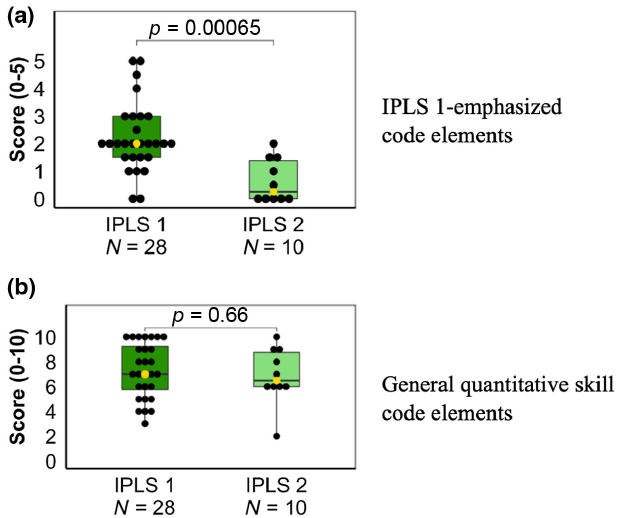
FIG. 4. Score comparison between those who had taken different IPLS courses. (a) Scores on the IPLS 1 emphasized elements of the code for those who took either IPLS 1 (dark green box plot) or IPLS 2 (light green box plot). Students who took IPLS scored significantly higher on these elements of the code than those who took IPLS 2. (b) Scores on the general quantitative skill elements of the code for those who took either IPLS 1 (dark green box plot) or IPLS 2 (light green box plot). There is no significant difference between the two groups on these elements of the code. All p values are from Wilcoxon